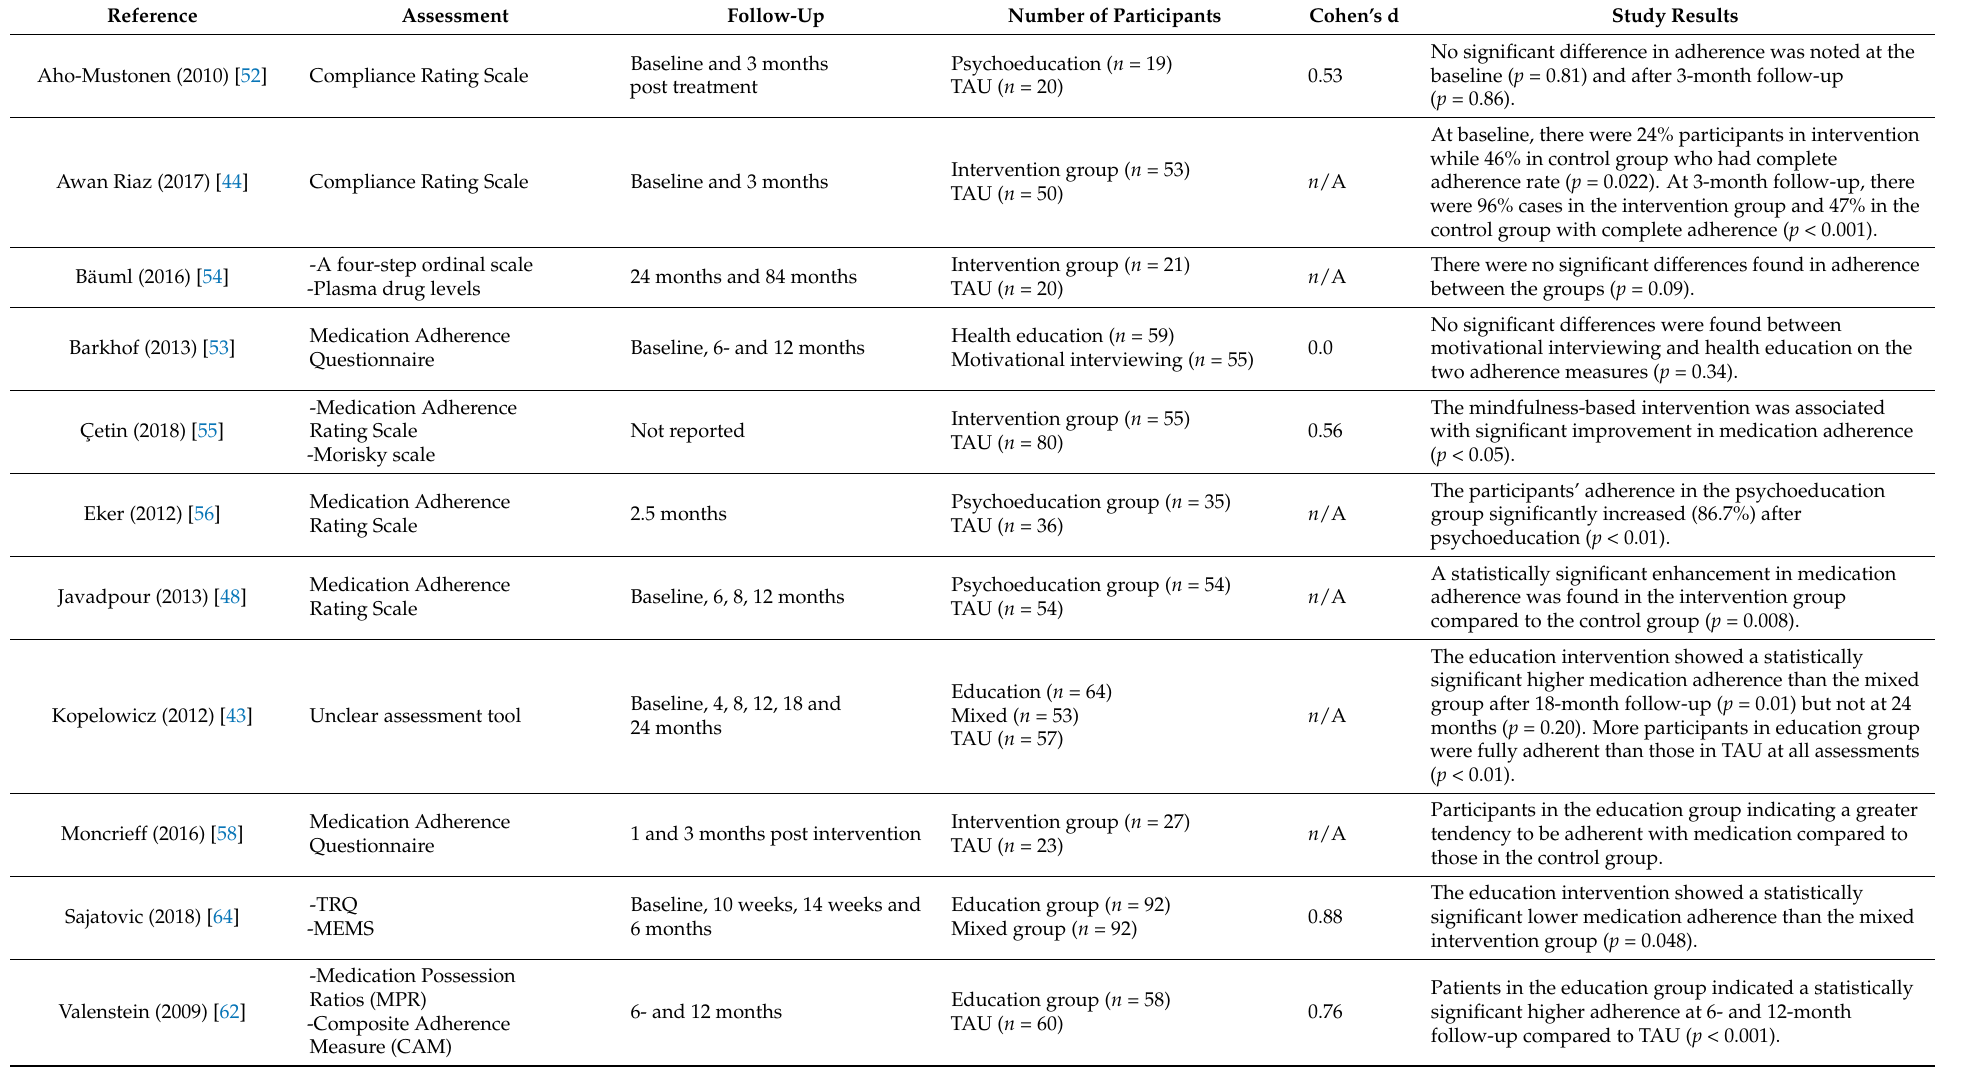
Table 4. Summary of results on the effectiveness of educational